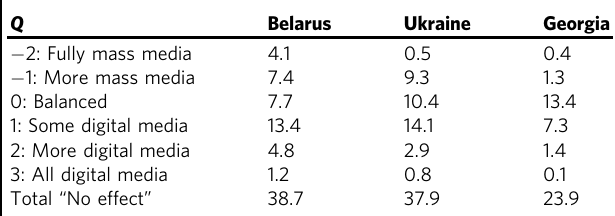
Table 3 Per cent of respondents in each country who replied “ No effect ” (Table 1, bottom row) versus digital-vs.-mass media, E .